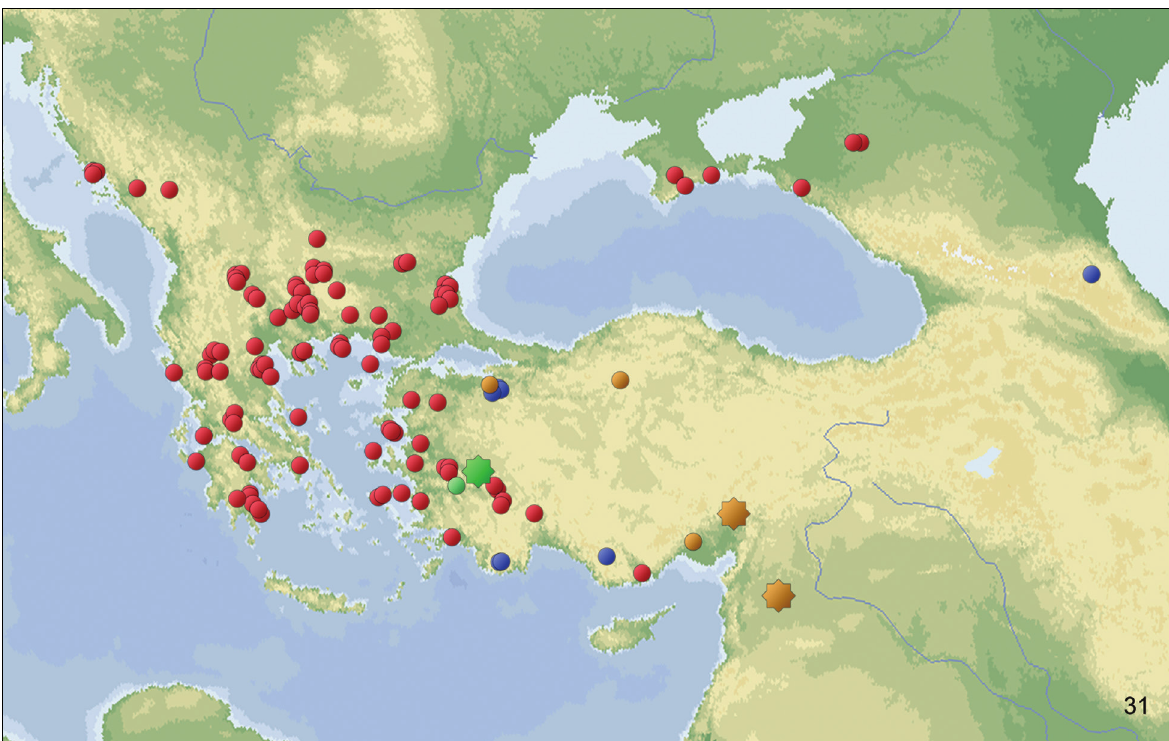
Figure 31. Distribution of Dilaridae in Southeast Europe and Anatolia (see geographical coordination and references of distribution records in Suppl. materials 1–2). Red = D. turcicus ; brown = D. anatolicus sp. n.; green = D. fuscus sp. n.; star = identified specimens without exact locality; blue = Dilar